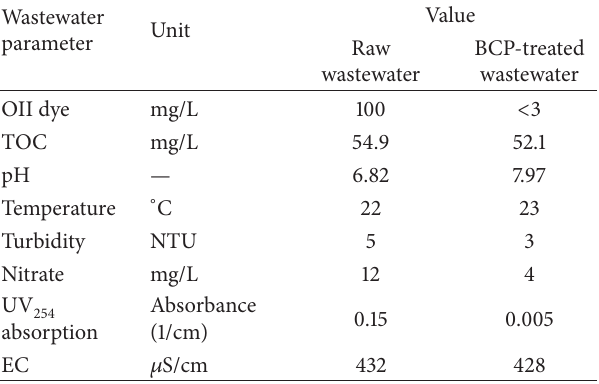
Table 6: The quality of simulated wastewater before and after treatment with BCP (OII concentration 100mg/L, pH 6.8, contact time 20 min, and BCP dosage